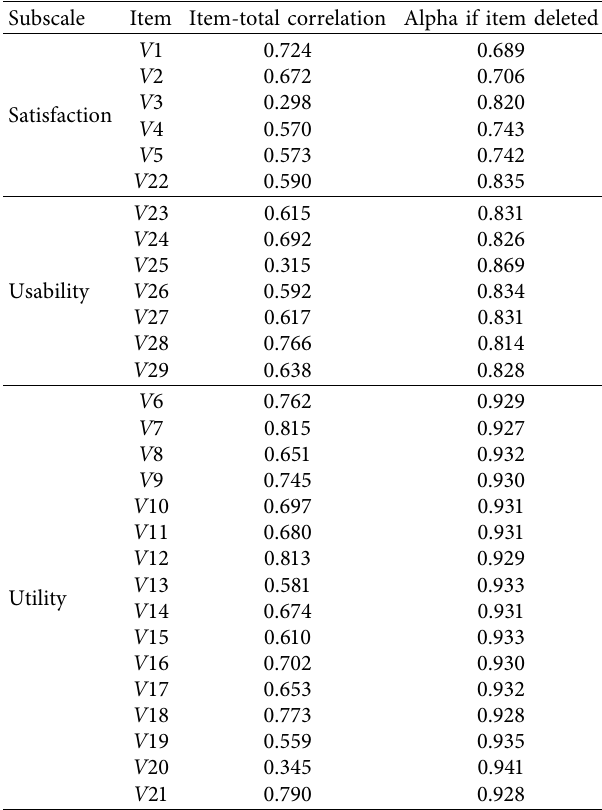
Table 1: Item-total correlations and alpha if item deleted. Subscale Item Item-total correlation Alpha if item